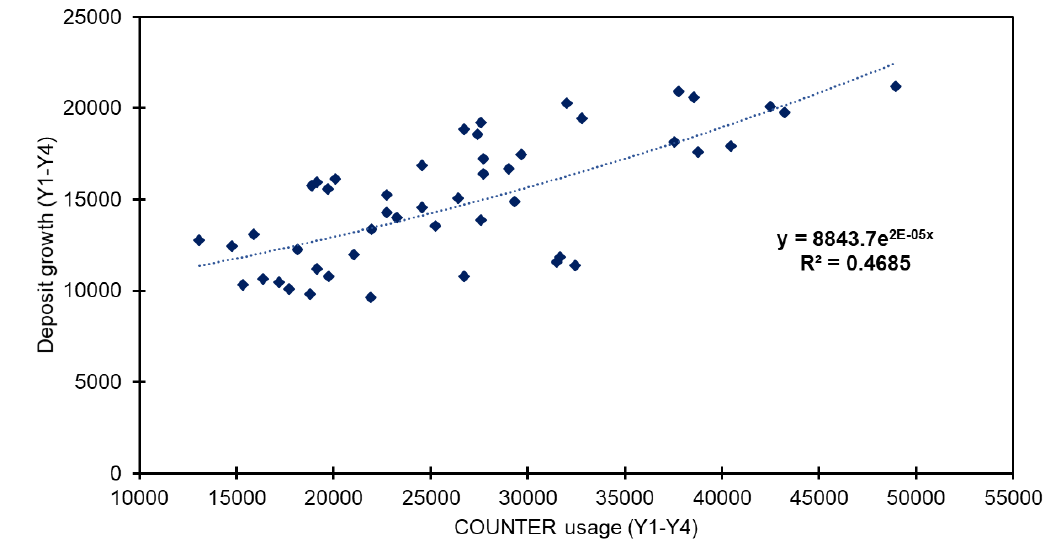
Figure 5. Exponential regression (r squared) for deposit growth and COUNTER usage